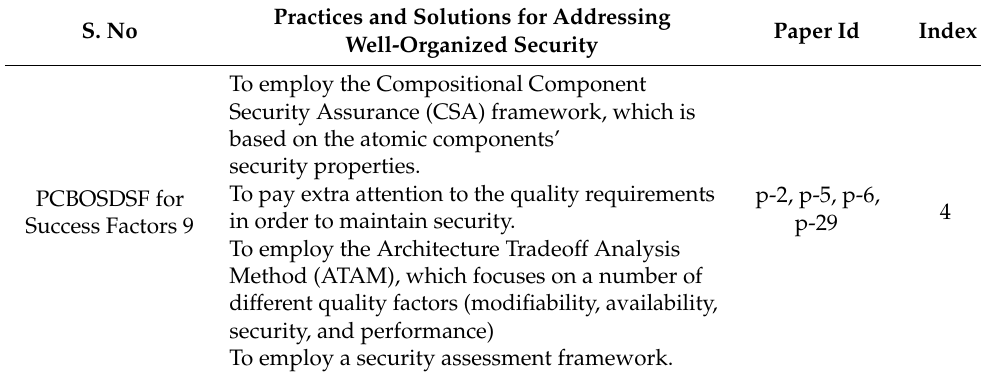
Table 13. CBOSDSF 9: Well-organized security.